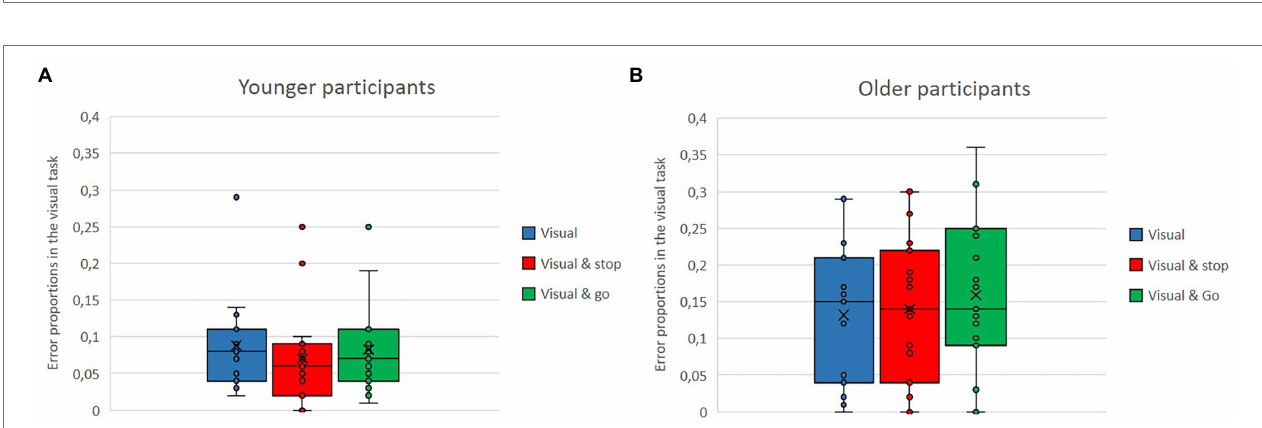
FIGURE 7 | (A,B) Means of response time in seconds in the go task, as single vs. dual-task conditions with either the visual or the cognitive secondary task for the older and the younger group.